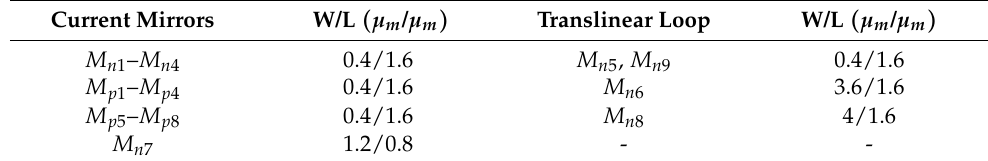
Table 2. Multiplier’s transistor dimensions.